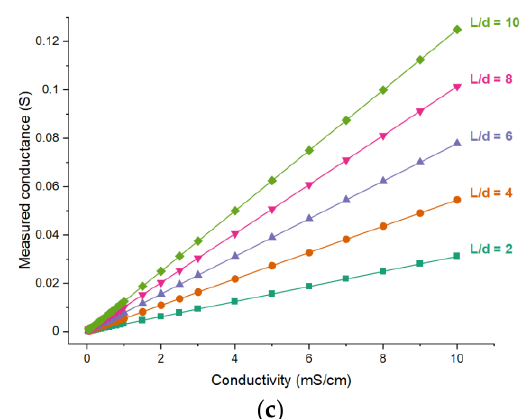
Figure 9. Simulation results for different electrode lengths: The dependence of ( a ) the real part of the impedance; ( b ) the imaginary part of the impedance; ( c ) the measured conductance on the conductivity of the solution when θ = 120°.